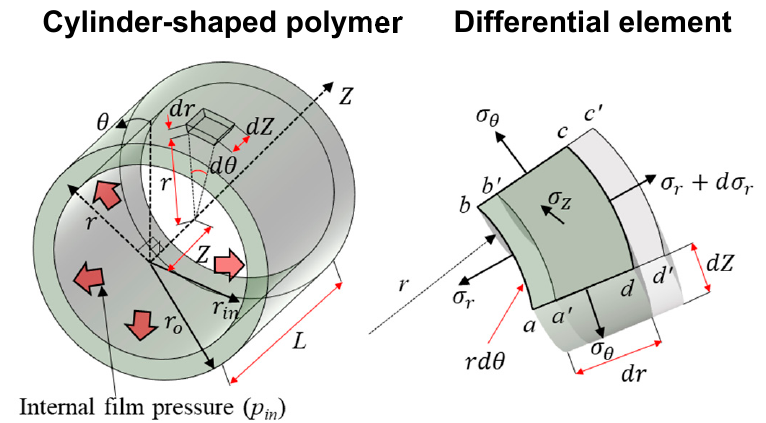
Figure 2. Cylindrical coordinate system of a cylinder-shaped polymer model loaded by a uniform internal film pressure and normal stresses on a differential element.